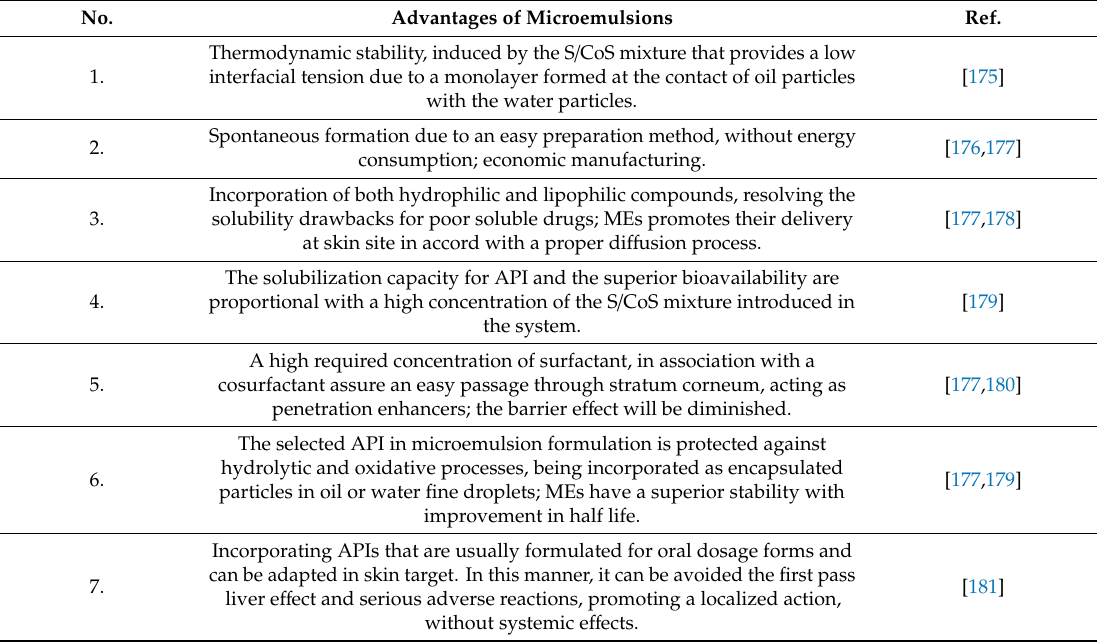
Table 2. Advantages of microemulsion (ME) formulation for topical delivery of